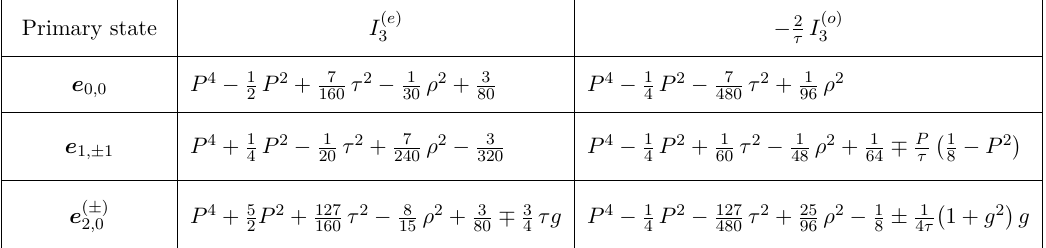
Table 2 . The eigenvalues of the local integrals of motion I ( e ) the W ( c, 2)